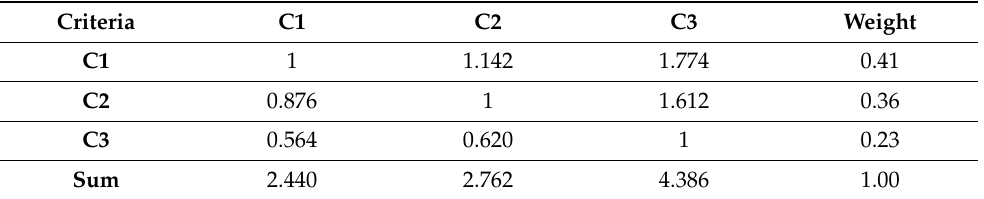
Table 12. Pairwise comparison matrix for forest land use suitability using he geometric mean of the preferences with the computed